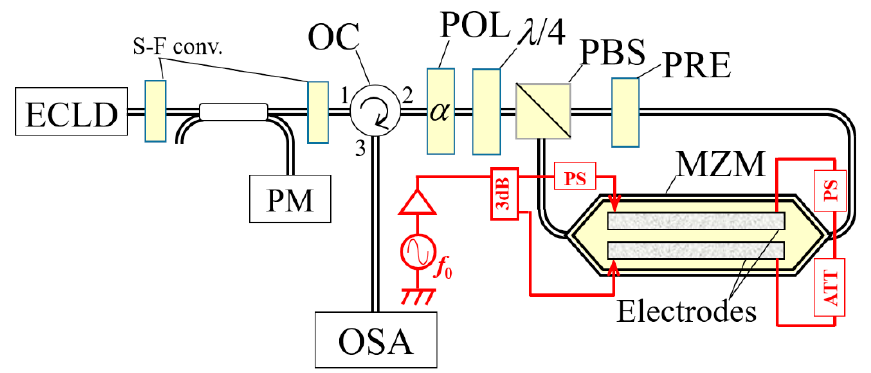
Figure 5. Experimental setup. Thin red lines are the RF signal connections, and double solid lines are connections for lightwave. ECLD: External-cavity diode laser, S-F conv.: PMF connector coupling a slow- (fast-) axis of the either PMF to a fast- (slow-) axis of the other, PM: optical power-meter, OC: Optical circulator, POL: Polarizer, λ /4: quarter-waveplate, PBS: Polarizing beam-splitter, PRE: Polarization-rotation element, MZM: Mach-Zehnder optical Modulator, OSA: optical spectrum analyzer, 3 dB: 3 dB RF hybrid coupler, PS: RF phase shifter, and ATT: Attenuator.